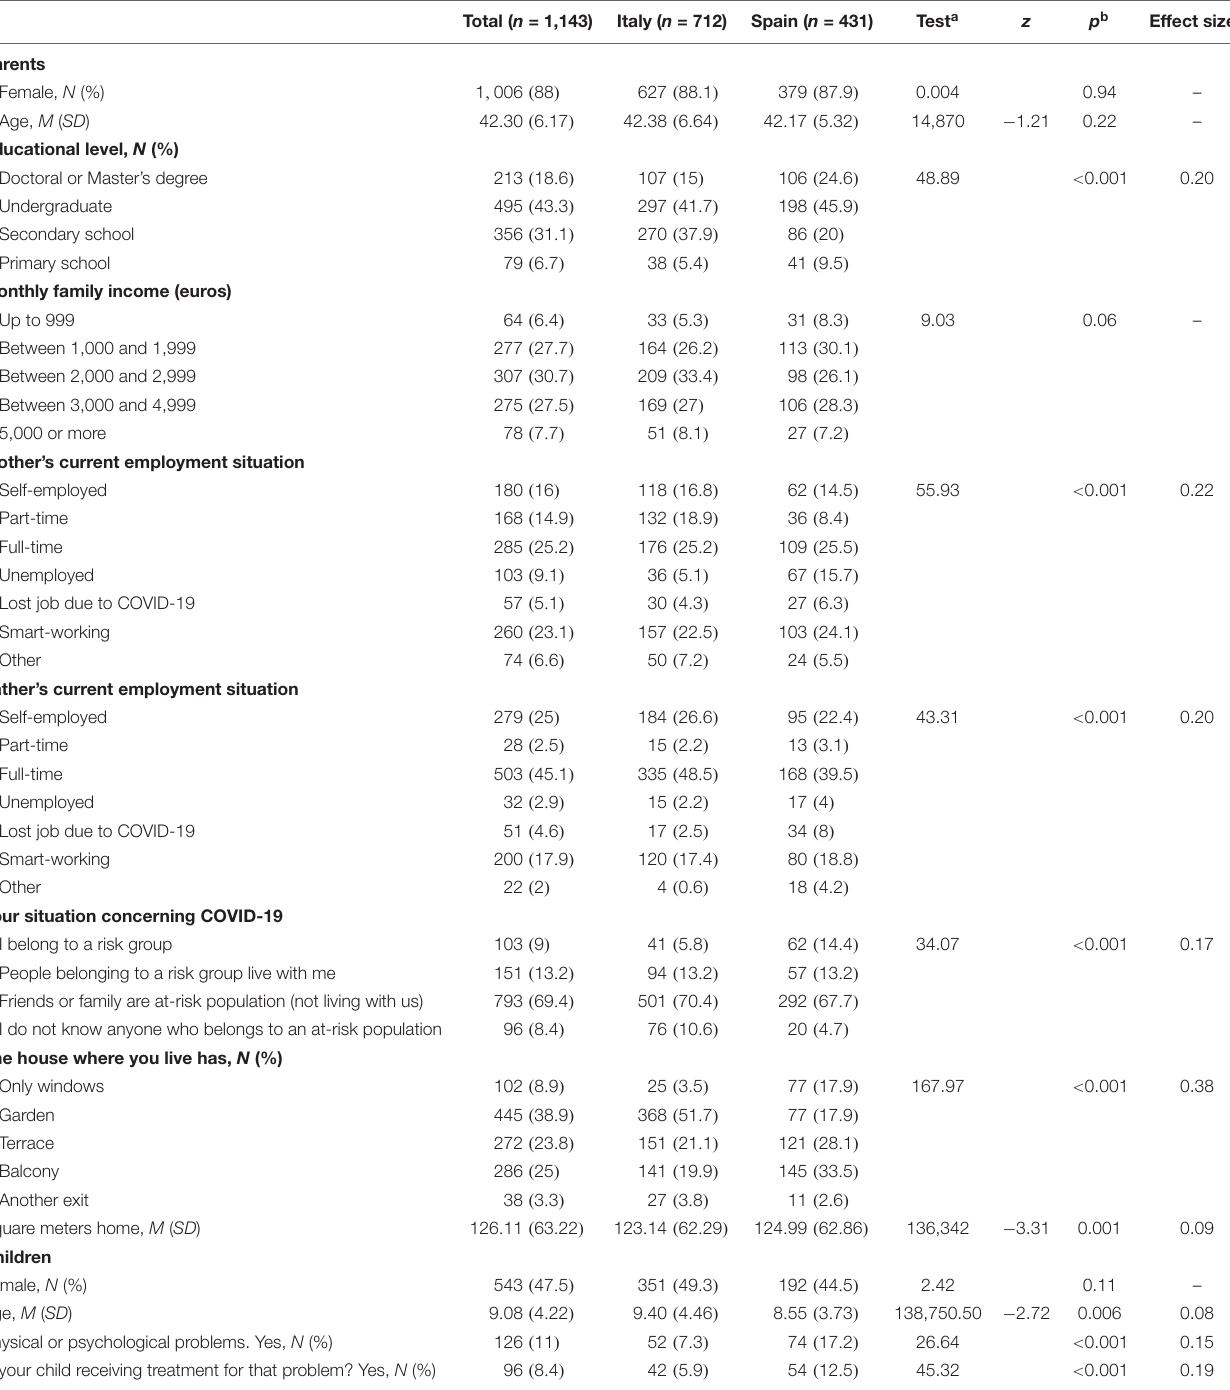
TABLE 1 | Sample characteristics and differences by